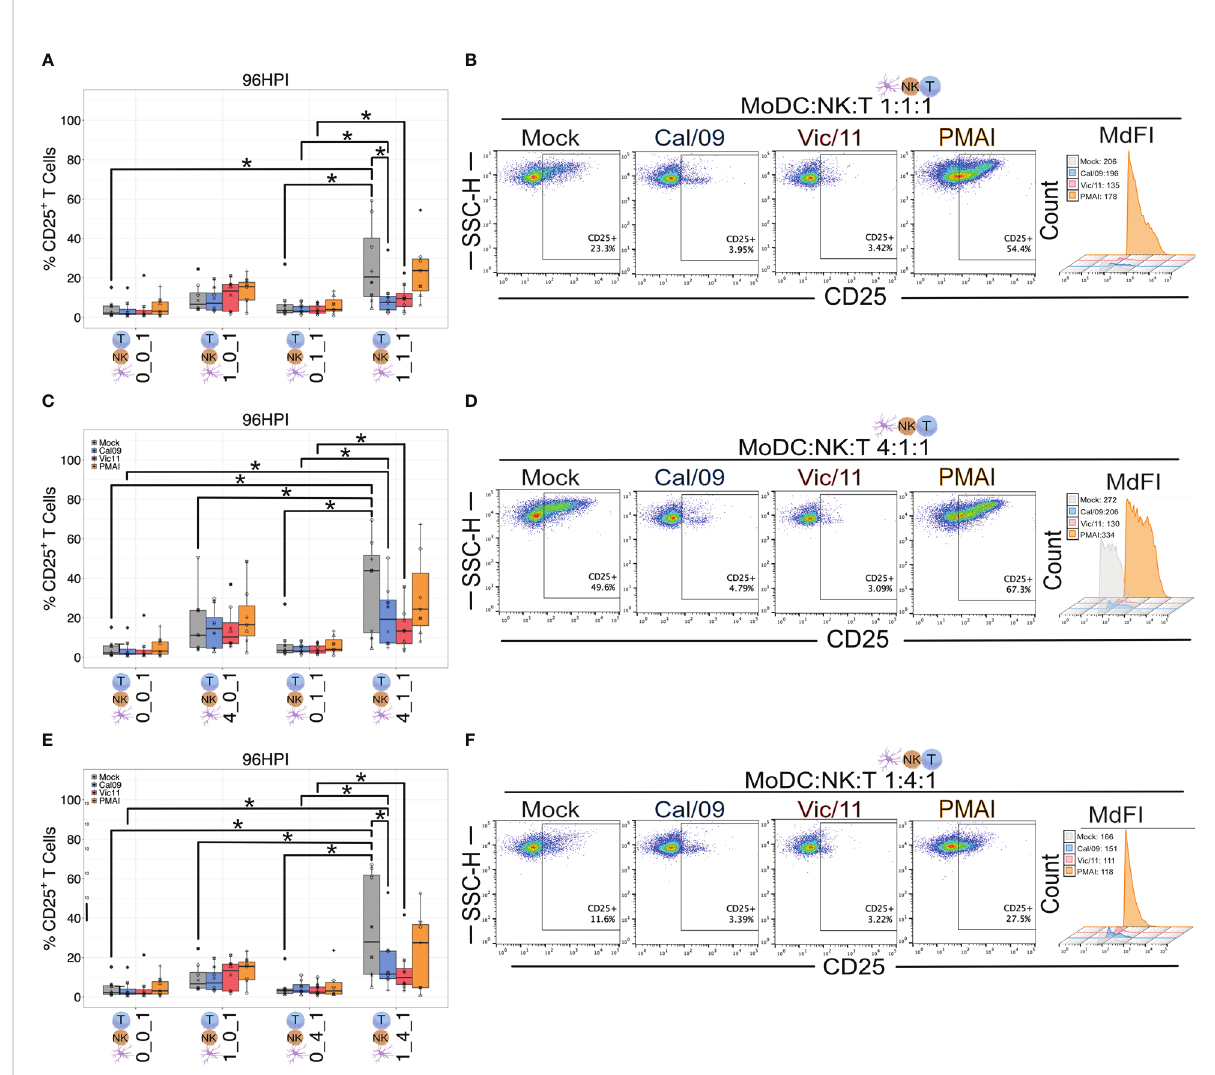
FIGURE 6 MoDC-NK cell cross-talk increases the frequency of a late marker of T cell activation. Summary plots of the frequency of CD25 + T cells after culture with mock-treated or Cal/09- or Vic/11-exposed MoDCs (MOI = 3) after 95 h co-culture with MoDCs and NK cells ( n = 8) at a MoDC to NK cell to T cell ratio of (A) 1:1:1, (C) 4:1:1, and (E) 1:4:1 as assessed by fl ow cytometry using an antibody speci fi c to CD25. Representative fl ow plots of the frequency of CD25 + T cells and MdFI after 95 h co-culture with Cal/09- or Vic/11-exposed MoDCs (MOI = 3) at a MoDC to NK cell to T cell ratio of (B) 1:1:1, (D) 4:1:1, and (F) 1:4:1. PMA/I treatment for 12 h served as a positive control. The same shape between conditions indicates that the data point is derived from the same donor. * p < 0.05, Wilcoxon signed-rank